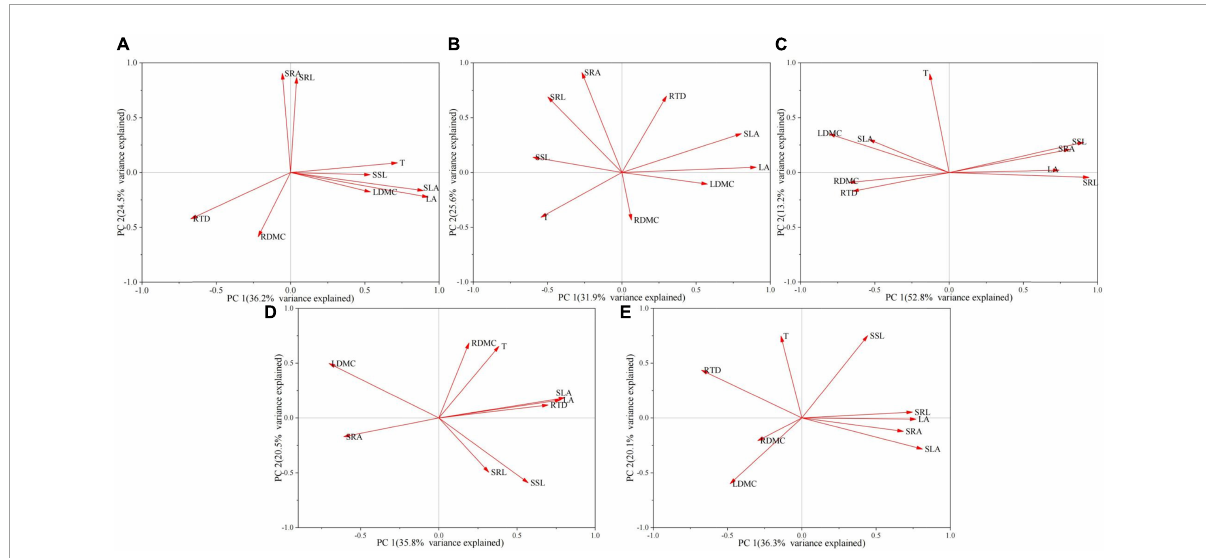
FIGURE3 Principal component analysis of functional traits of Abies georgei var. smithii seedlings in different age classes. (A) 1–2 years old, (B) 3–4 years old, (C) 5–6 years old, (D) 7–8 years old, (E) 9–10 years old.